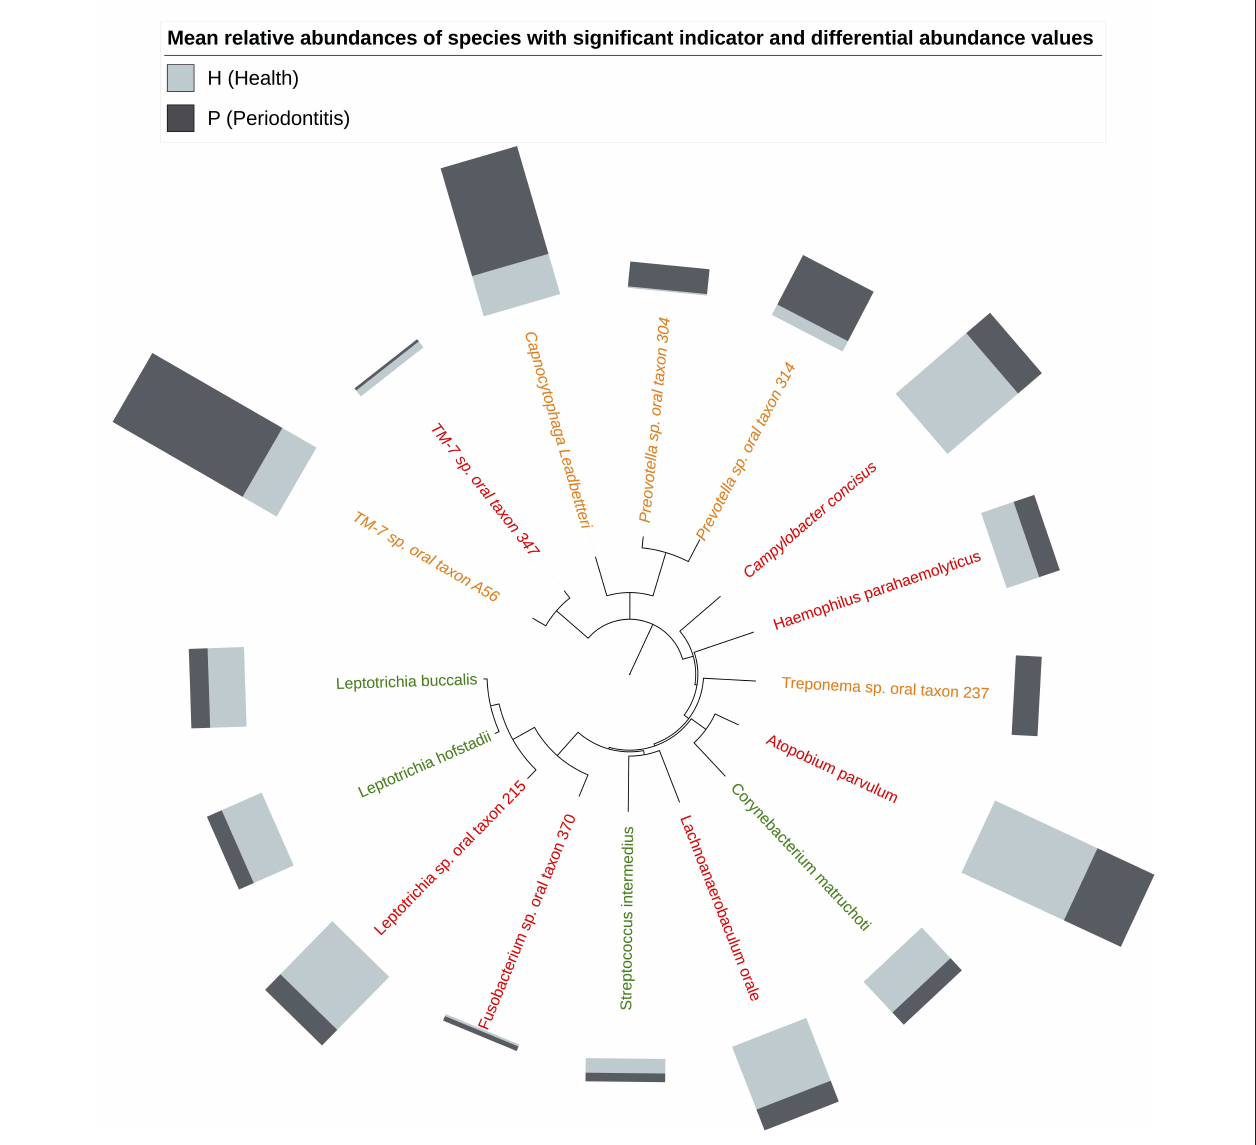
FIGURE 5 | Phylogenetic relationship of Indicator (H indicators in green, P indicators in red) and DA species (in orange). Bars represent mean relative